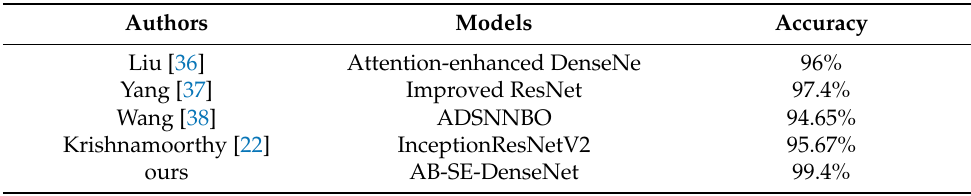
Table 8. Comparison with models proposed in the related literature.